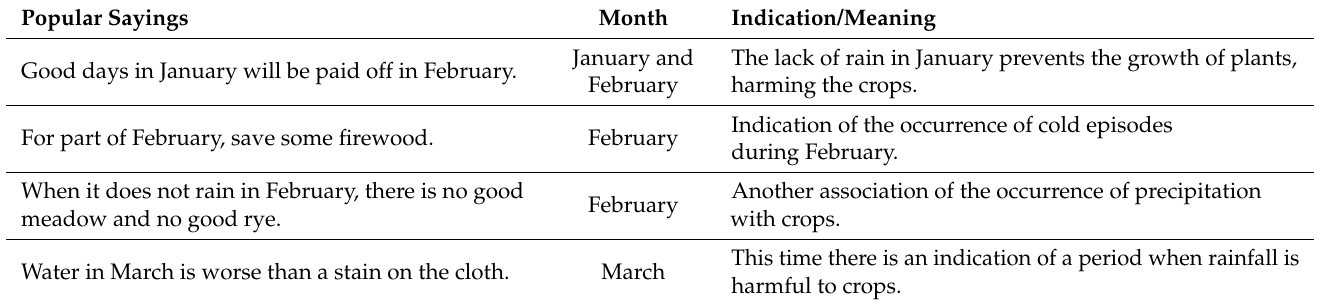
Table 3. Popular sayings collected by Alberto Vieira Braga in his work “ De Guimar ã es: Tradiç õ es e Usanças Populares